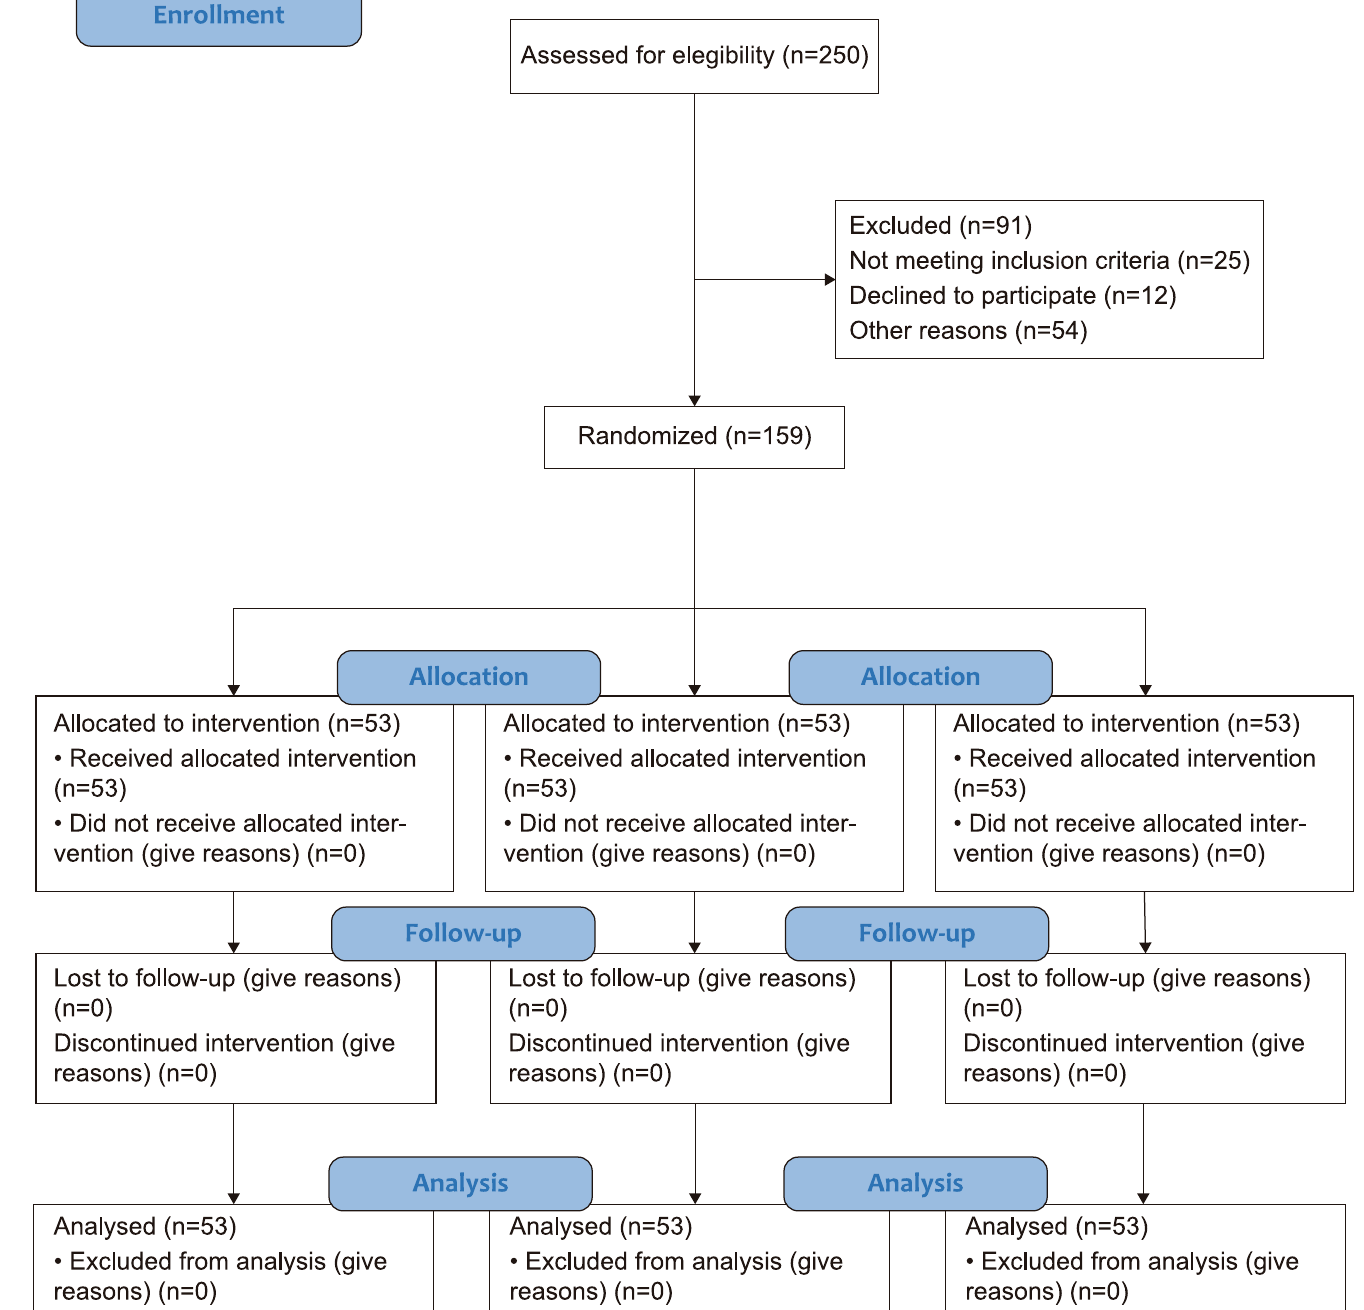
Fig 1. Flow Diagram of the progress through the phases: enrolment, intervention, allocation, follow-up and analysis.